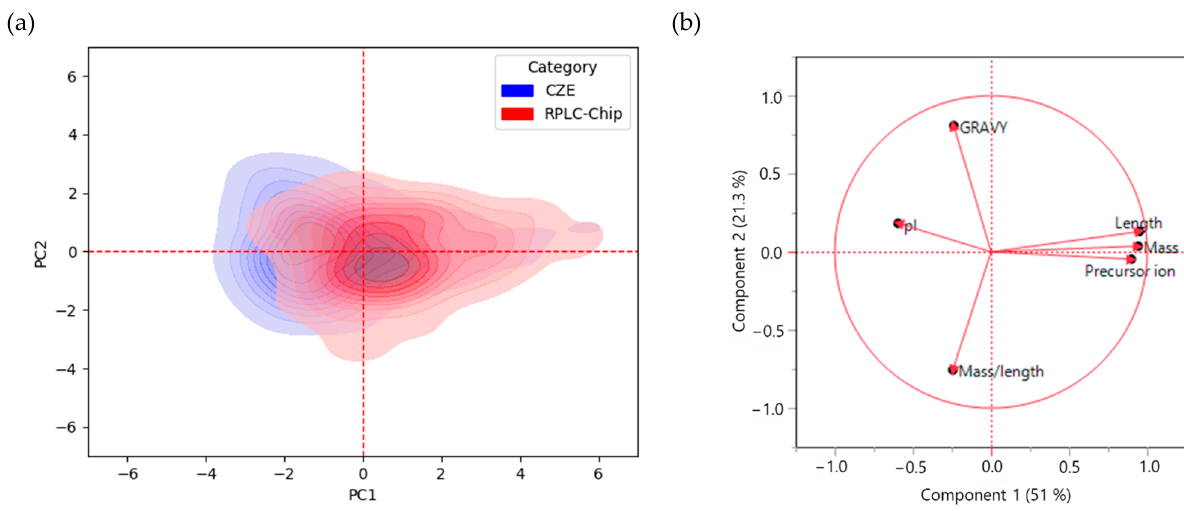
Figure 5. ( a ) Density PCA plot representing peptides identified in RPLC-Chip (Red) and CZE (Blue) according to their physicochemical properties. ( b ) Loading plot including the physicochemical properties as variables.